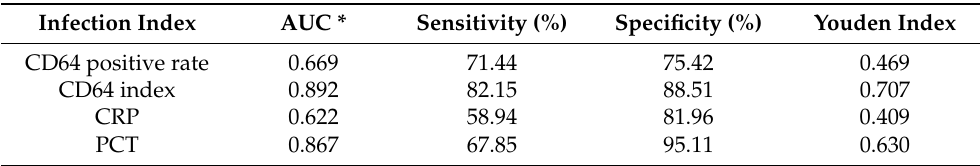
Table 4. Diagnostic efficacy of infection indicators for acute pancreatitis complicated with abdominal